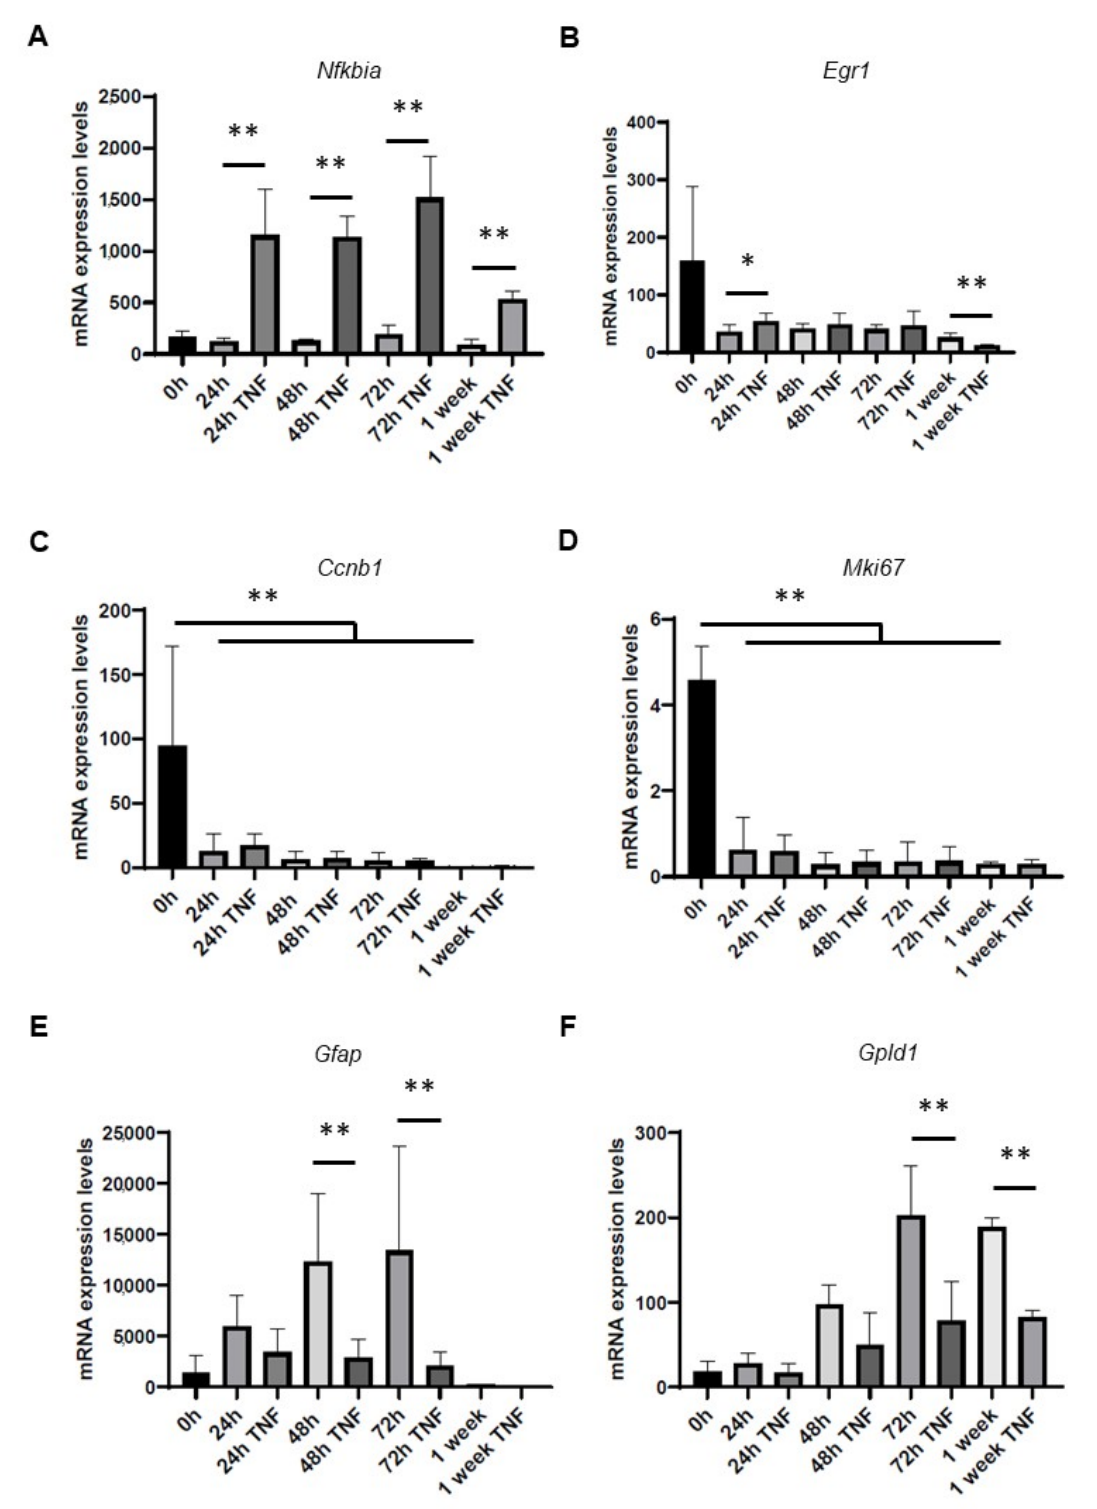
Figure 2. Gene expression levels of NSC and astrocyte markers following treatment of NSCs with TNF during astrocytic differentiation. NSPs were differentiated into astrocytes with or without exposure to TNF (50 ng/mL) for 24 h, 48 h, 72 h, and 1 week. RT-qPCR analyses show the mRNA expression levels of ( A ) Nfkbia , ( B ) Egr1 , ( C ) Ccnb1 , ( D ) Mki67 , ( E ) Gfap, and ( F ) Gpld1 . Results are expressed as mean ± standard deviation of 2 − ∆ Ct normalized to beta actin levels. * p < 0.05; ** p < 0.01, n ≥